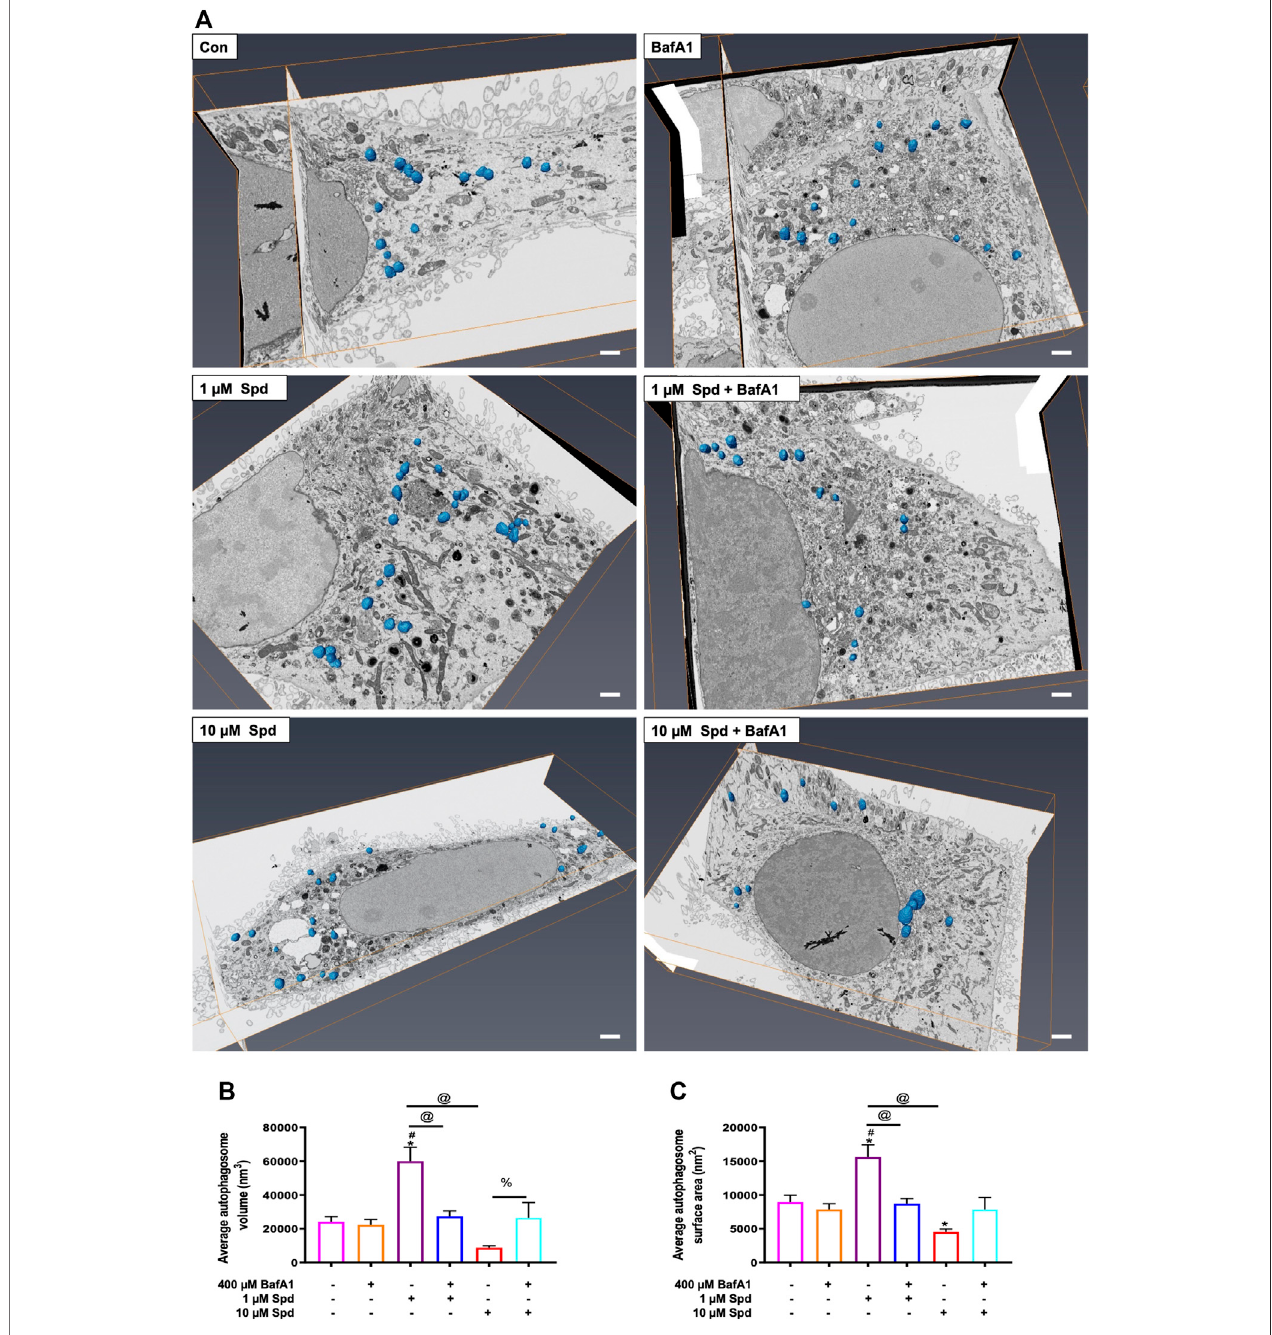
FIGURE6| Effect ofspermidine on cargoclearanceand sizeregulation. (A) Orthogonal viewsofFIB-SEMstackshowingsegmented autophagosomes (scale bar: 1 μ m). (B) Morphometric analysis of autophagosome volume and (C) surface area following treatments. Data are presented as mean ± SEM. A total of 15 – 25 autophagosomesanalysedper treatment group.Spermidine atlowconcentrationinducesautophagosomescapable oflargevolumeclearance.*= p < 0.05vs.control, # = p < 0.05 vs. BafA1, @ = p < 0.05 vs. 1 μ M Spd and % = p < 0.05 vs. 10 μ M Spd.